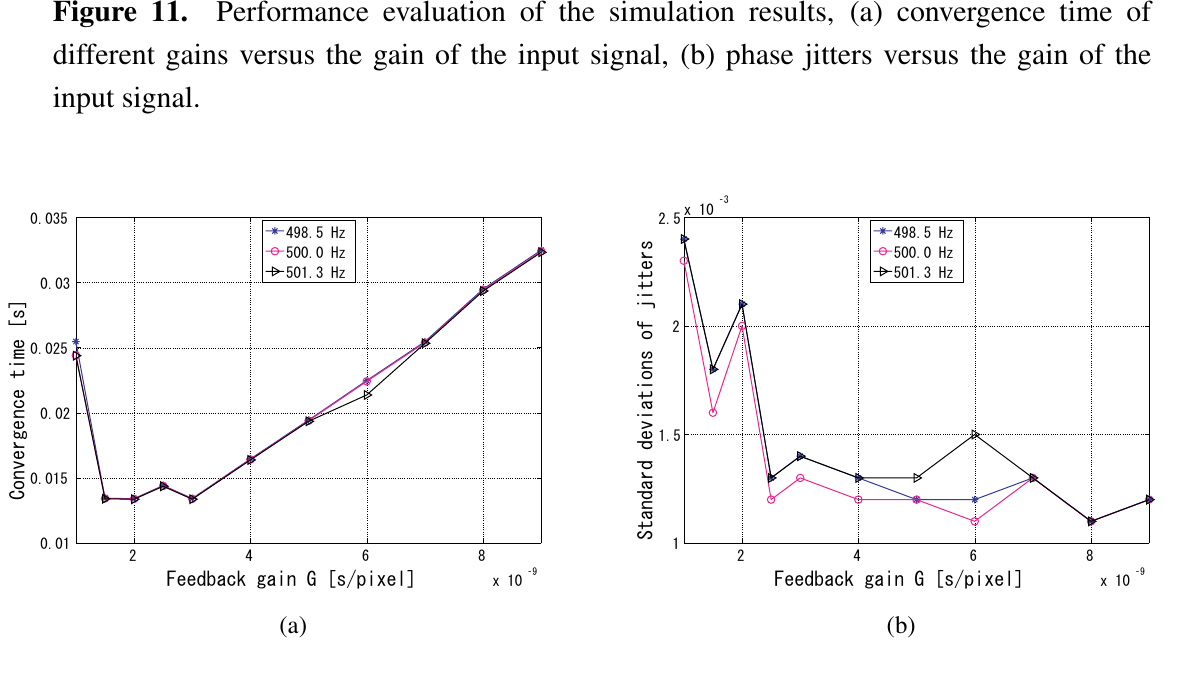
Figure 11 (b) shows the jitters for different gains and reference frequencies. The jitters were evaluated for the duration between the convergence time and 2 s from the beginning of the measurement. Leastwise, the relative phase between the reference and output is very stable and on the order of 10 − 3 rad within this range of the